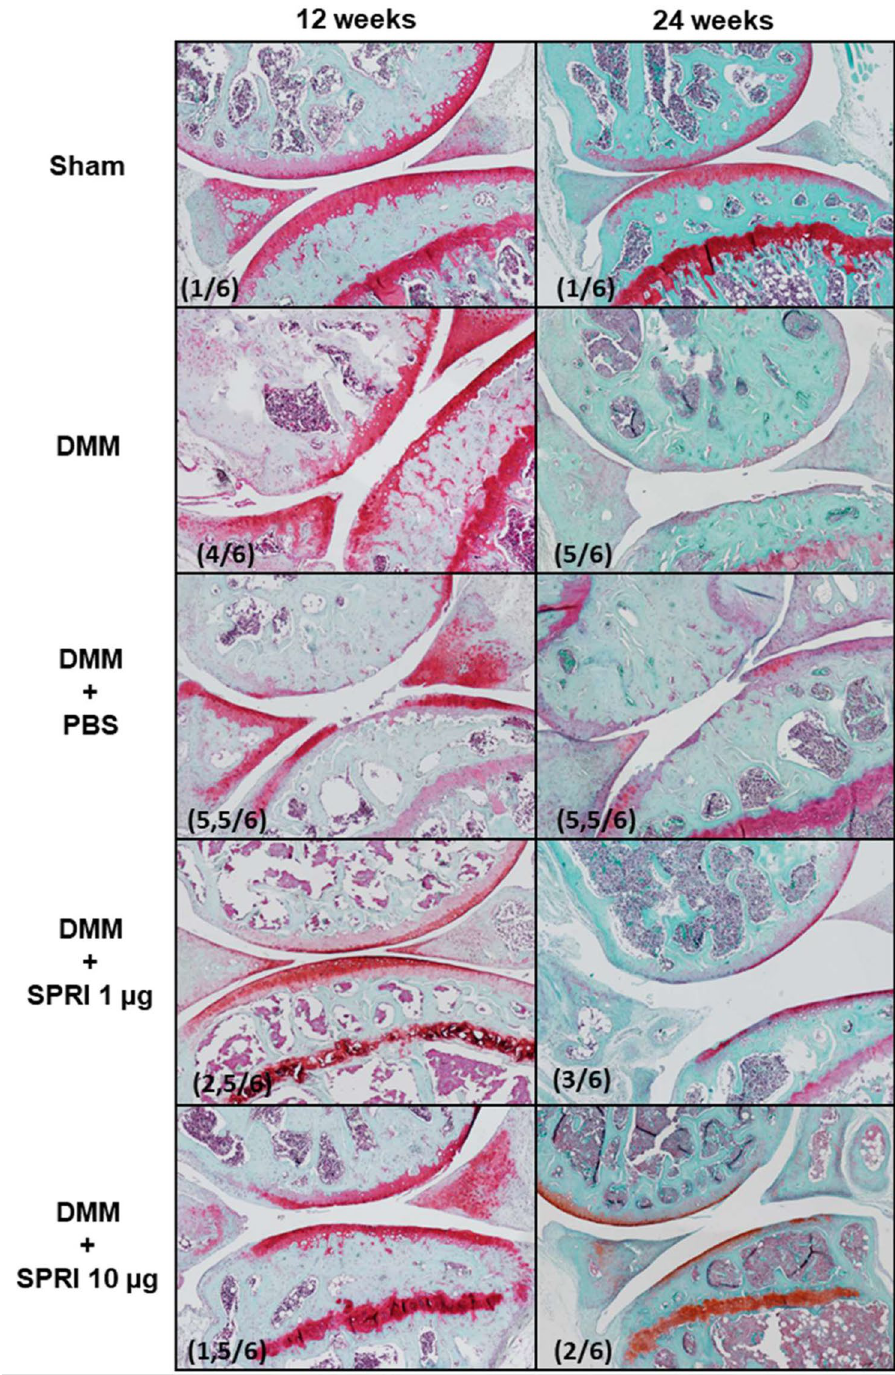
Figure 4. A representative histological sections from Shams, DMM, DMM + PBS, DMM SPRI1 and DMM SPRI10 at 12 W (left) and 24 W (right) after surgery. OARSI scores are indicated into